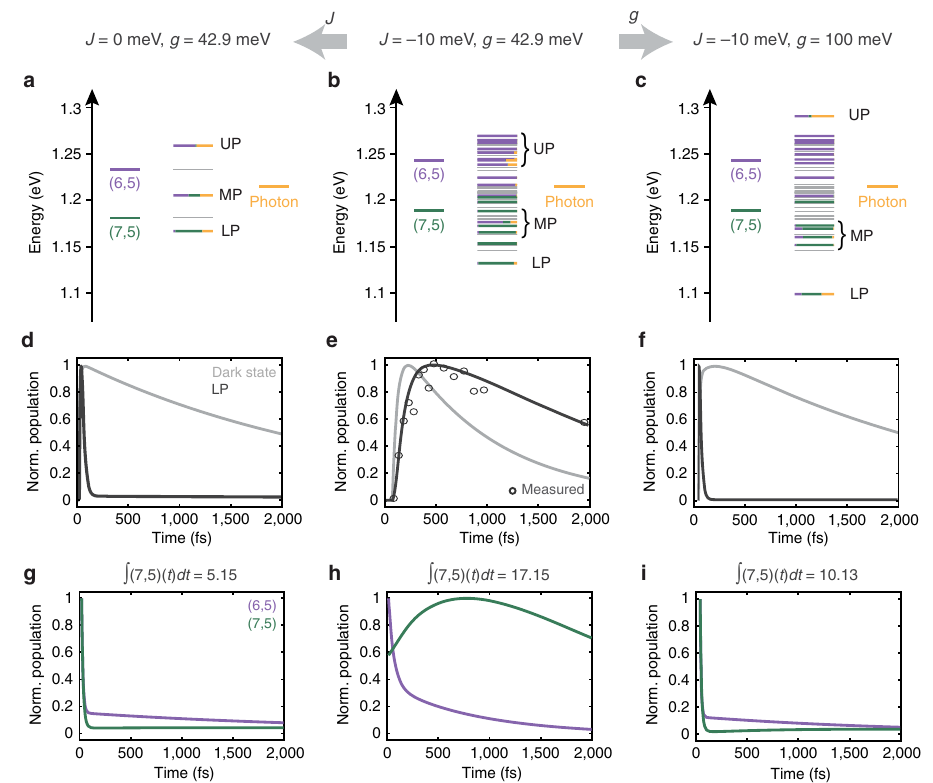
Fig. 5 | System parameters affecting the energy landscape and population dynamics. Energy level diagrams of the mixed (6,5)/(7,5) microcavity in the absenceofinter-tubecoupling( J )( a ),whenboth J andlight-mattercoupling( g )are present with comparable amounts ( b ), and when g is signi fi cantly larger than J ( c ). Bright states are color-coded to illustrate the contribution from the cavity photon and the carbon nanotubes (CNTs), and dark states (states with transition dipoles smallerthan0.01%ofthemaximumdipolestrengthineachcase)areshowningray. The speci fi c J and g values used for each case are displayed on top. See also Sup- plementary Fig. 16 for the simulated spectra. b is a replicate of the energy level diagram in Fig. 4c plotted on a different energy axis. d – f show the corresponding